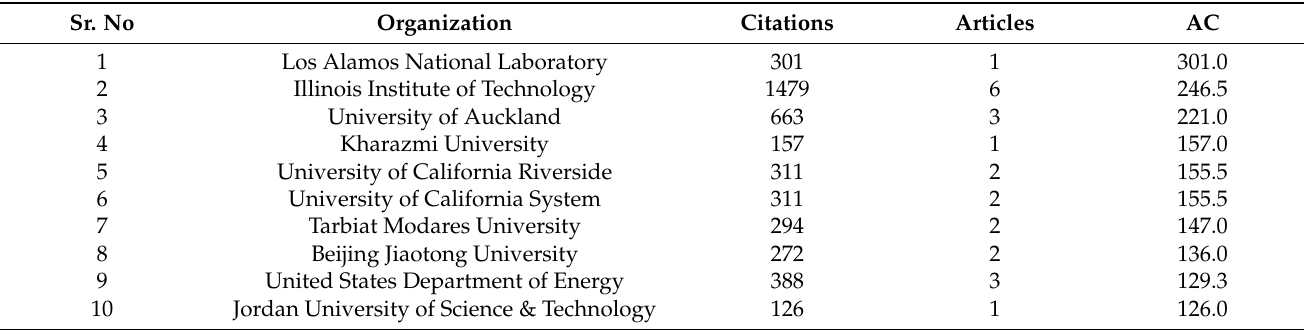
Table 4. Top 10 institutions with more average citations in research